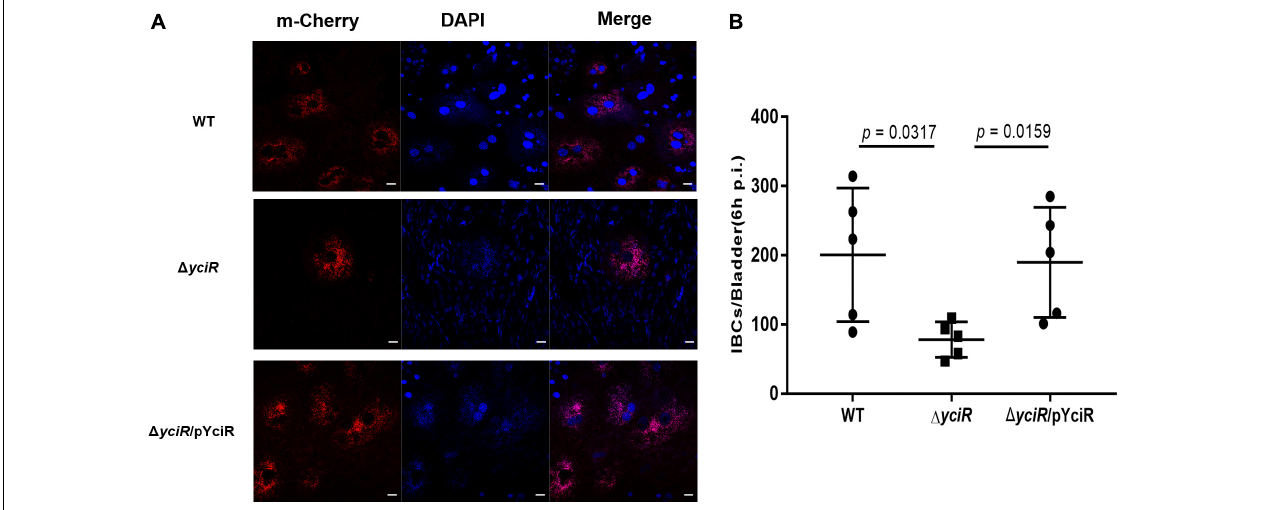
FIGURE 4 | YciR promoted the number of IBC formations in Balb/c mouse bladders. (A) Microscopic examination of IBC formation in mice bladders infected with WT, (cid:49) yciR , and (cid:49) yciR pYciR strains in Balb/c mice killed at 6 hpi after transurethral catheterization. The harvested bladders were prepared as described in the Materials and Methods section for visualization by confocal laser scanning microscopy. Observation of intracellular WT, (cid:49) yciR , and (cid:49) yciR pYciR (red) associated with the bi-nucleus of superficial umbrella cells of the bladder (blue). Bar = 20 µ m. (B) IBC enumeration in Balb/c mice bladders infected by the WT, (cid:49) yciR , and (cid:49) yciR pYciR strains. The number of IBCs was counted via confocal laser microscopy for the whole bladder. A single Z-section of a superficial umbrella BEC of Balb/c revealed an IBC using confocal laser microscopy. Each dot represents the IBC number in one mouse bladder. Three independent experiments were performed, and p -values were calculated using a two-tailed Mann–Whitney non-parametric comparison.